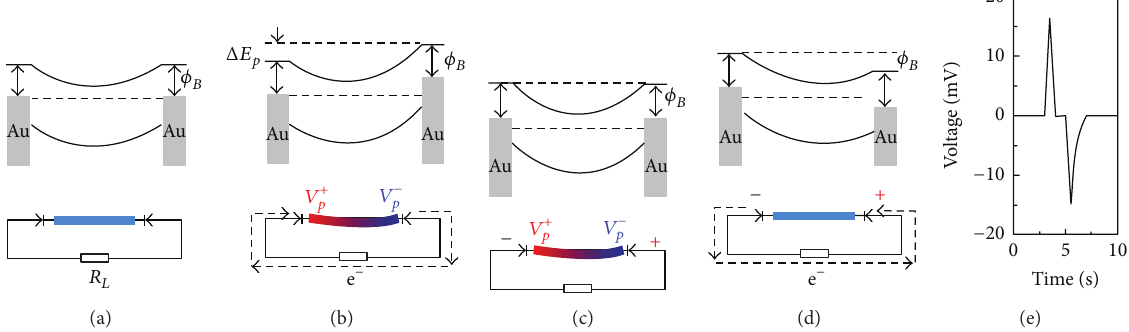
Figure 3: Band diagram for understanding the charge output and flow process in the nanogenerator with compressed nanowire. (a) Before pressing. (b) Nanowire vertically compressed by external force. (c) Equilibrium state under strain state. (d) Release of pressure. (e) Output